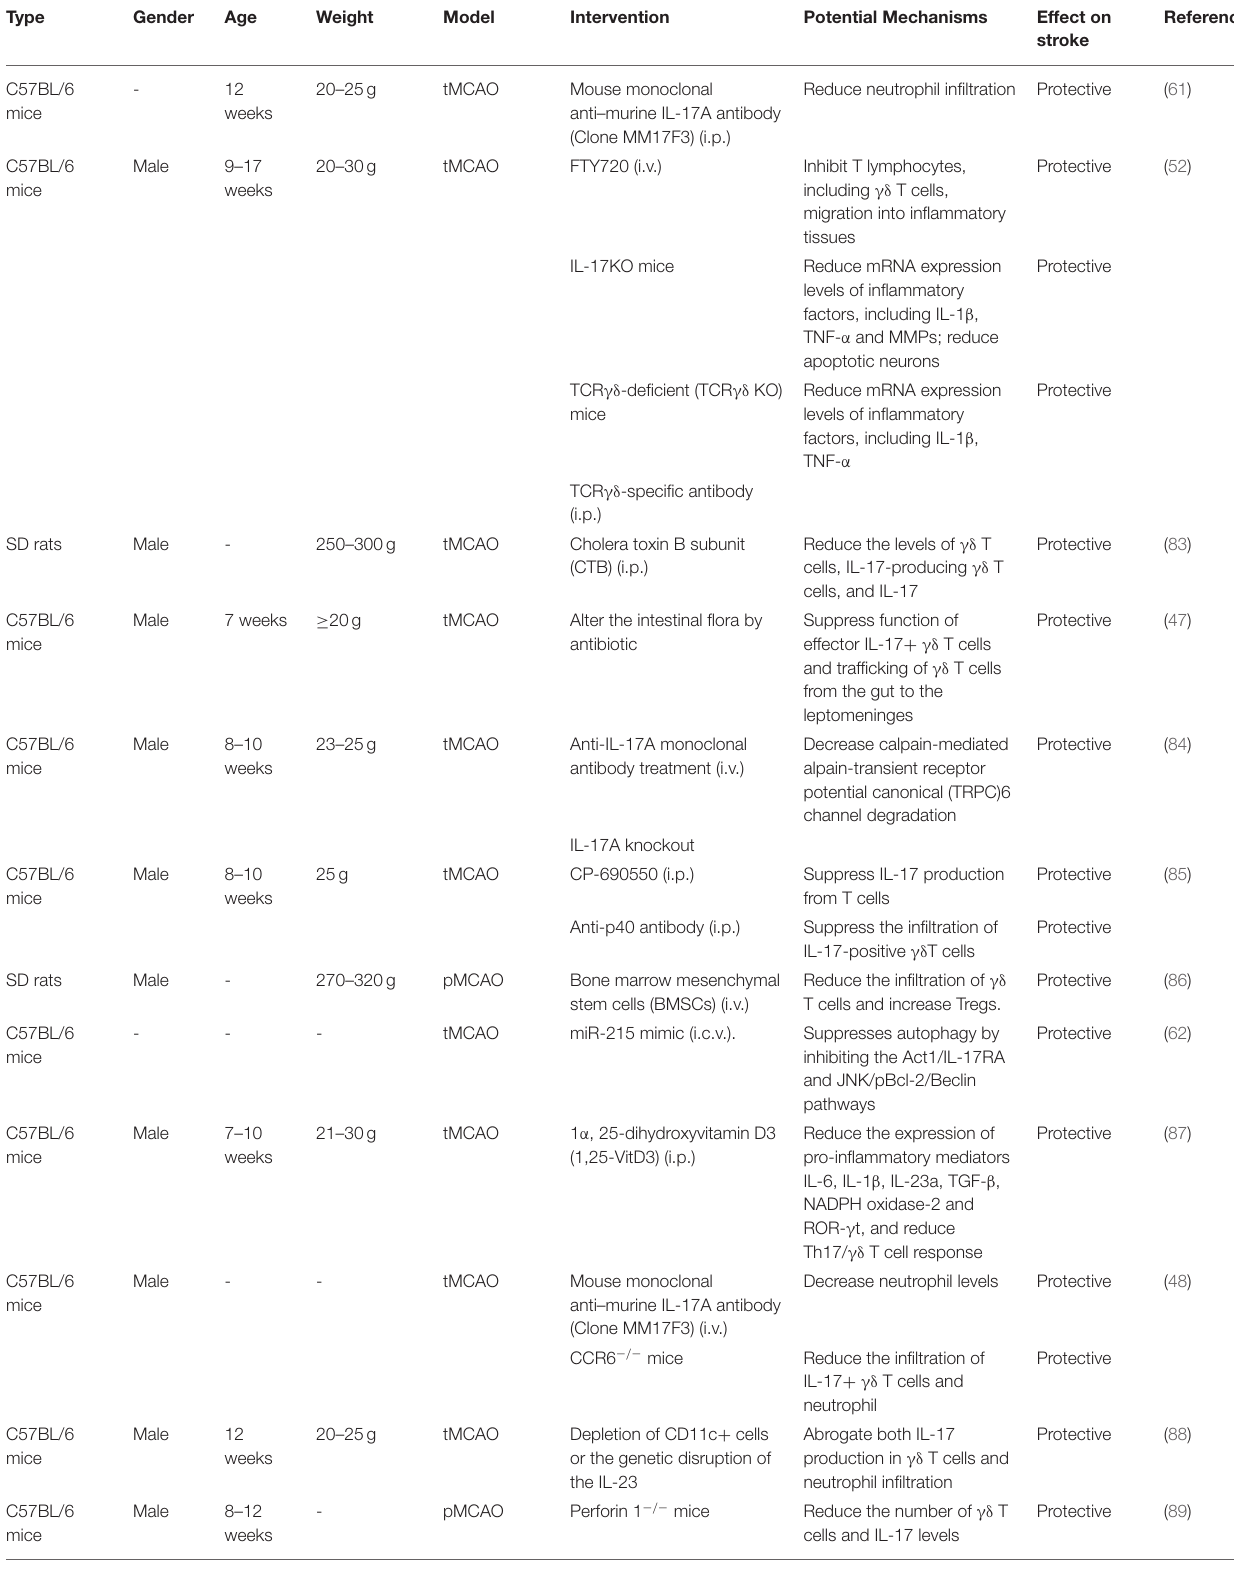
TABLE 1 | Therapies targeting at γδ T cells and related cytokines in